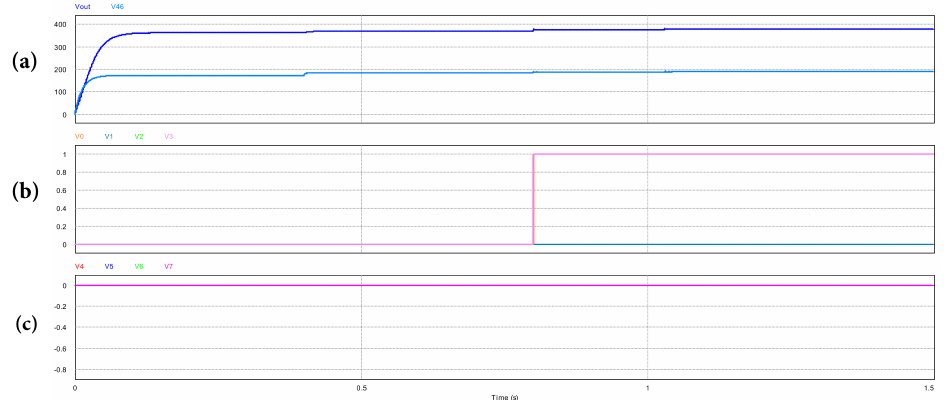
Figure 36. Sixth set of simulation results, ( a ) 380 V boost converter ( SPV 1, blue) and 190 V boost converter ( SPV 2, cyan), ( b ) SC vector, the least significant four bits ( c ) SC vector, the most significant four